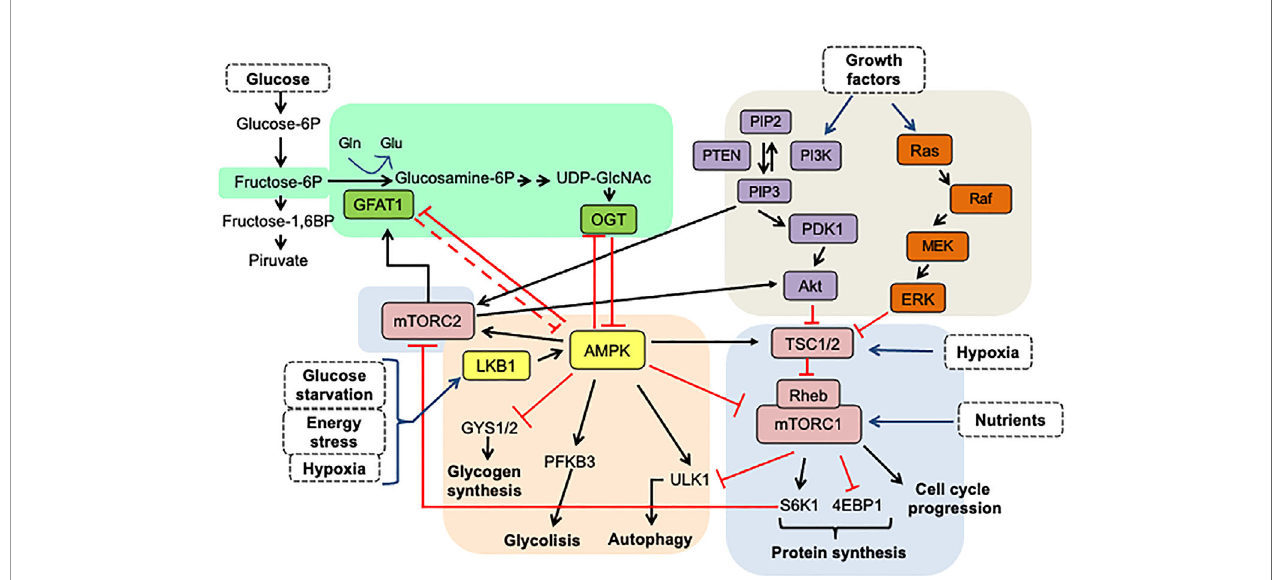
FIGURE 5 | The interplay between HBP, mTOR, and AMPK signaling pathways. The HBP pathway senses glucose, glutamine, and nucleotide levels to produce UDP-GlcNAc, the primary metabolite for protein O-GlcNAcylation, via the enzyme OGT. GAFT1 and OGT suppress the AMPK activity, which is a master energy stress sensing enzyme. AMPK activated by phosphorylation favors the processes that produce ATP over the biosynthesis of molecules. Therefore, AMPK functions as a negative regulator of mTORC1, which induces translation and promotes cell growth when there are high levels of nutrients. Furthermore, AMPK activates TSC1/ 2, which ensures complete suppression of mTORC1 activity. Also, AMPK and mTORC1 pathways feedback take over the ULK1 activation, a protein necessary for the induction of autophagy. On the other hand, growth factors activate the AKT and MAPK kinase pathways, which convergence in the same way in the inactivation of the TSC1/2 complex, the negative regulators of mTORC1. On the other hand, the mTORC2 complex activity is controlled by glucose and acetate levels through acetyl-CoA, an intermediary metabolite in glycolysis, fatty acid catabolism, and the HBP pathways. mTORC2 also converges with the HBP pathway in the stimulation of GFAT1. In consequence, the interplay between these signaling pathways is involved in nutrient sensing as a means of regulating cell activity and growth and, more importantly, in reacting to changes in the microenvironment of the tumor. The arrows indicate: ! , activation signals; ┴ , inhibition